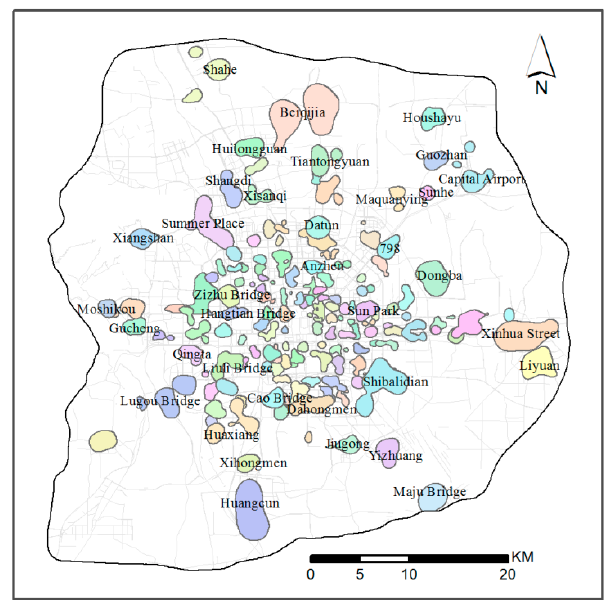
Figure 2. Distribution of 150 places within the Sixth Ring Road of Beijing.